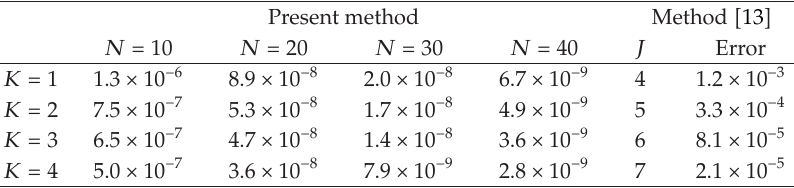
Table 5: Comparison of maximum absolute errors for Example 3.3.